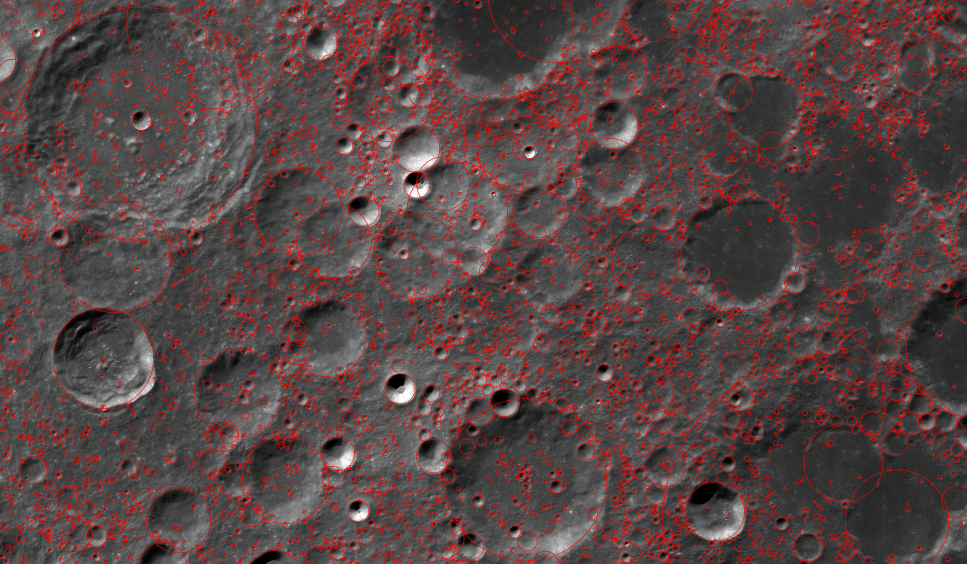
Figure 12. Image of lunar surface with crater coordinates.